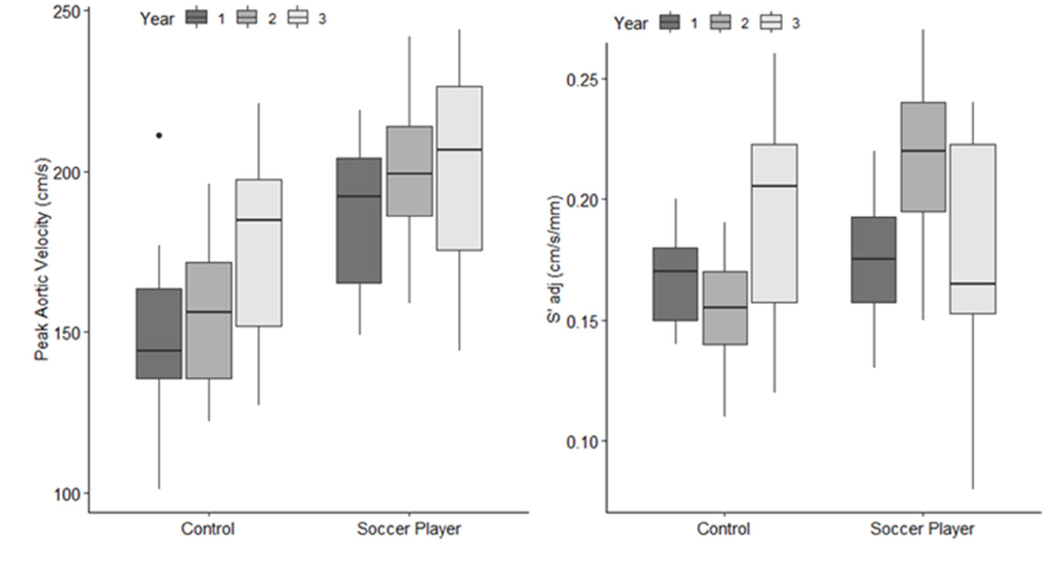
Figure 4. Changes in heart rate (HR), cardiac index (QIndex), stroke volume index (SVIndex), and arterial-venous oxygen difference (AVO 2 difference) at approximately 45% 𝑉(cid:4662) 𝑂 (cid:2870)(cid:3043)(cid:3032)(cid:3028)(cid:3038) in the control participants and soccer players over the course of the three-year observational study. All values are median and inter-quartile range. Unnithan et al. [1]. Reprinted with permission from Unnithan et al., [1], 2022, John Wiley and Sons.